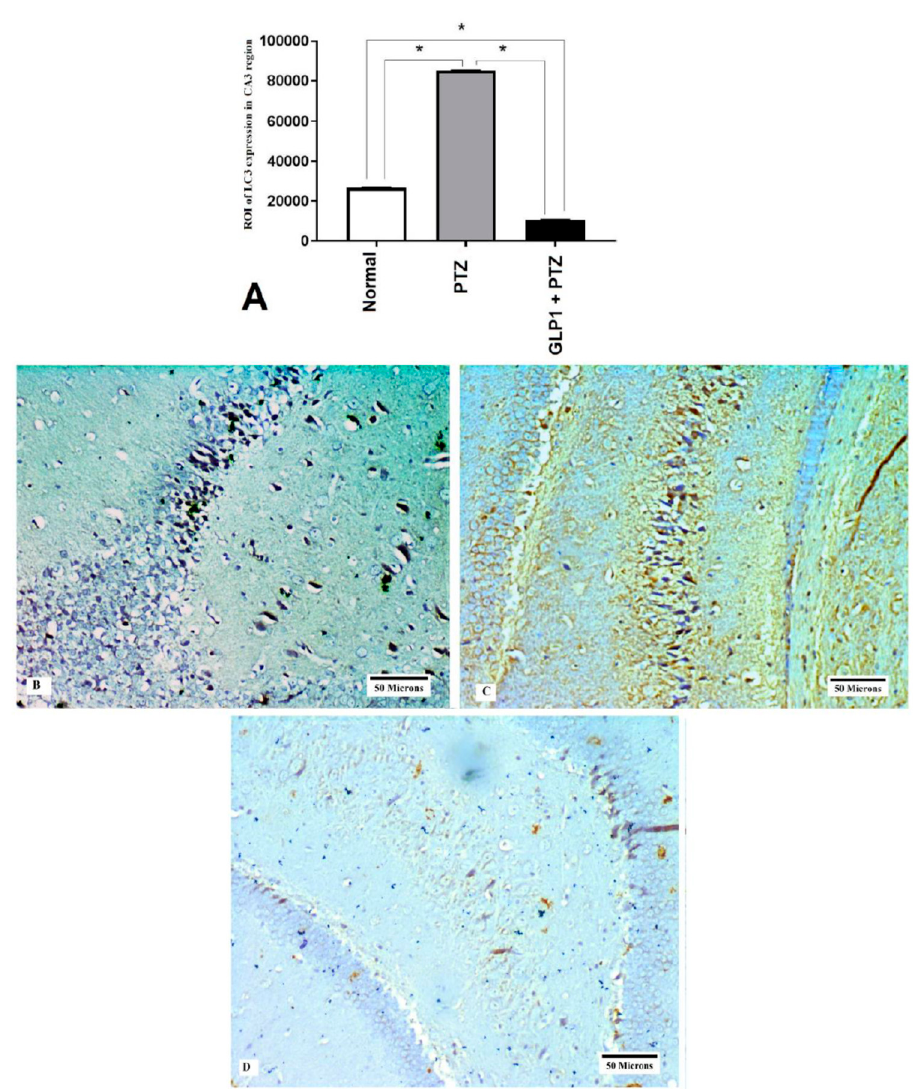
Figure 6. E ff ects of GLP1 on autophagic marker (LC3) expression in CA3 hippocampal region. Score of expression of LC3 in di ff erent groups ( A ), brain sections shows negative expression of LC3 in CA3 hippocampal region in normal group ( B ), brain sections showing marked LC3 expression in CA3 hippocampal region in PTZ group ( C ) and brain sections showing mild LC3 expression in CA3 hippocampal region in GLP1 + PTZ group ( D ). One-way ANOVA with Tukey posthoc test. *, Statistically significant di ff erence between two groups.